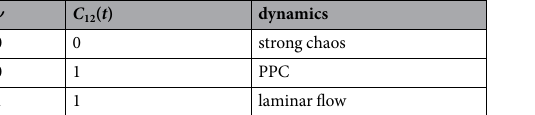
Table 2. Combining the scaling exponent ν and the level of the cross-correlation at finite time, C 12 ( t ), allows to classify the three possible types of dynamics (compare Fig.